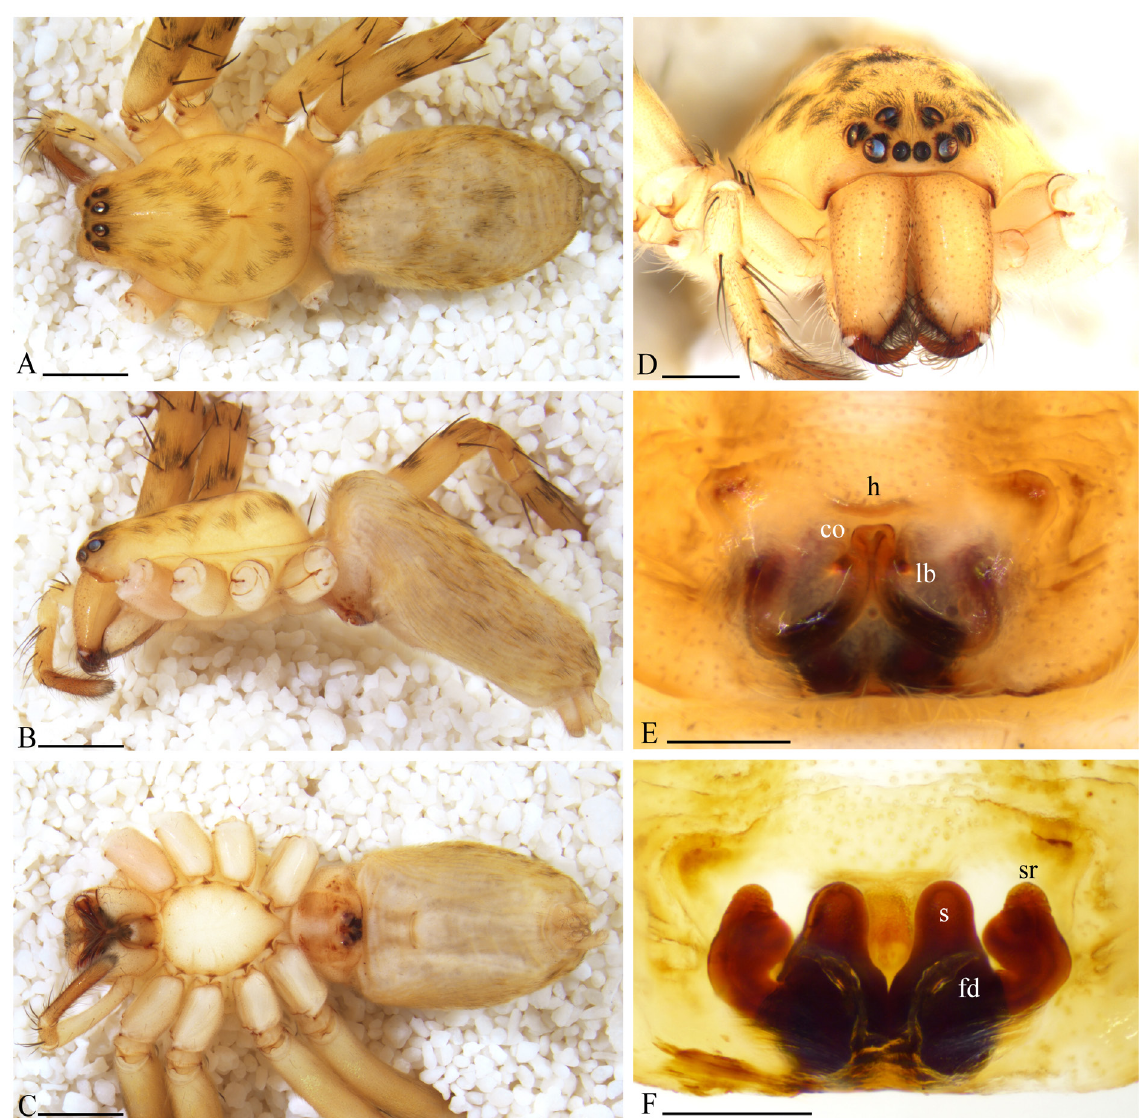
Fig. 16. Anyphaena jimenezi sp. nov., holotype, ♀ (CNAN-T01529). A . Dorsal habitus. B . Lateral habitus. C . Ventral habitus. D . Prosoma, anterior view. E . Epigynum, ventral view. F . Epigynum, dorsal view. Scale bars: A–C = 1.0 mm; D = 0.5 mm; E–F = 0.2